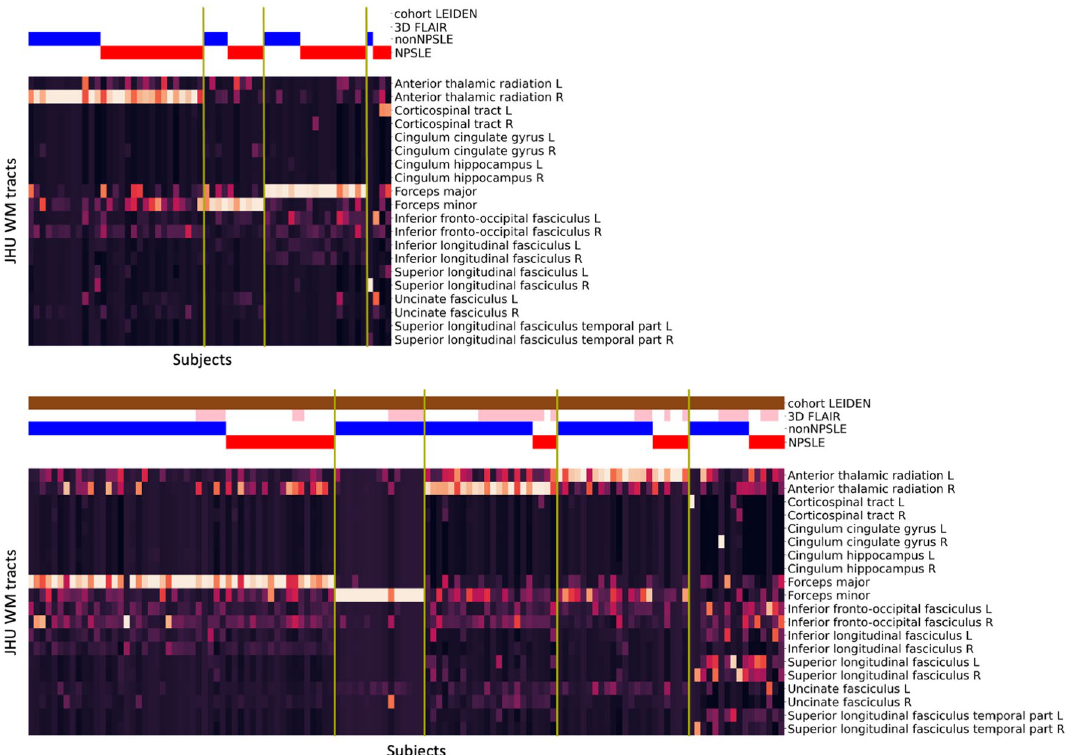
Figure 6. Sensitivity analysis on each cohort separately. Cluster analysis on Lund (top) and Leiden cohort (bottom). The horizontal bars at the top show additional information: Leiden cohort (brown) complemented by the Lund cohort, 3D-FLAIR (pink) complemented by 2D-FLAIR, non-NPSLE (blue), NPSLE (red). FLAIR, Fluid-attenuated inversion recovery; NPSLE, Neuropsychiatric systemic lupus erythematosus.